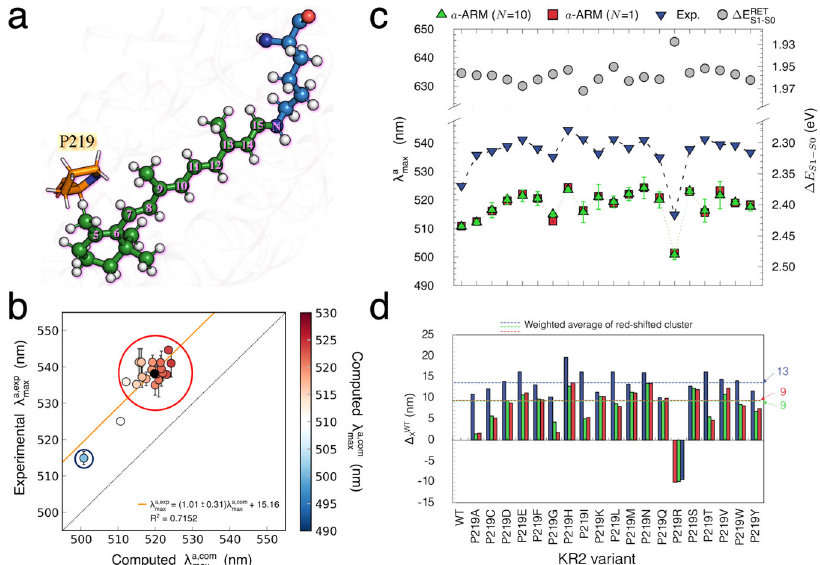
Fig. 5 Computed vs experimental trend in maximum absorption wavelength. ( a ) Scheme of the retinal proton Schiff base of WT- KR2. The residue P219 Þ and measured ð Δ E Exp Þ vertical excitation energy for WT-KR2 is located near the β -ionone ring. ( b ) Correlation plot between computed ð Δ E a (cid:1) ARM S1 (cid:1) S0 S1 (cid:1) S0 rhodopsin and 19 of its mutants (P219X, with X = A, C, D, E, F, G, H, I, K, L, M, N, Q, R, S, T, V, W, Y). The red circle indicates the red-shifted mutant cluster whose weighted average value is marked with a black circle. The blue circle indicates the only blue-shifted mutant of the set. ( c ) Maximum absorption wavelength ( λ a max , nm) and ( Δ E a − ARM S1-S0 , eV) for wild-type KR2 and 19 of its P219X variants. The experimental values (blue down triangles) are presented along with the a -ARM values predicted by using the average of n = 10 replicas (green triangles), and the representative replica with Δ E a-ARM S1- Δ E RET S1-S0 ), outside the protein S0 closest to the average (red squares). The values for the retinal chromophore (gray circles) calculated in vacuum ( environment, are also presented. Row data is provided in Supplementary Table 2. ( d ) Relative observed and computed Δ E a-ARM S1-S0 changes ( Δ , X WT ) with respect to WT. Row data is provided in Supplementary Table 3. The dashed lines show the values corresponding the weighted averages of the red-shifted cluster. S 0 and S 1 energy calculations were performed at the CASPT2(12,12)//CASSCF(12,12)/AMBER level of theory using the 6-31G(d) basis